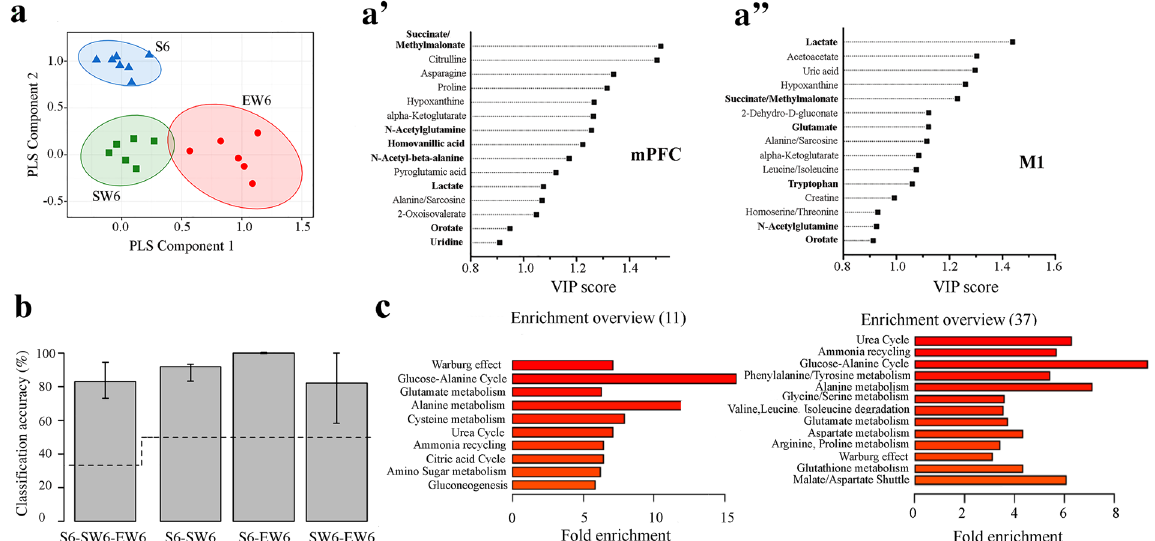
Figure 7. PLSDA and associated VIP classification model. By combining the mPFC and M1 analyses, data from S6, EW6, and SW6 were used in the PLSDA to determine the overall variation between treatment conditions. ( a ) PLSDA plot showing significant separation of EW6 from S6 and SW6 in Component 1, and additional separation of S6 from SW6 and EW6 in Component 2. Each symbol indicates data from one mouse. Ellipses represent a confidence interval of 95%. VIP score plots for mPFC (a’) and M1 (a”), showing the 15 metabolites with the highest VIP scores. The bold text indicates the metabolites identified by LME analyses. ( b ) Classification accuracy of the logistic regression with ℓ2 regularization penalty. Error bars represent a non-parametric 95% confidence interval for the true accuracy estimated from the cross-validation data. The lower end of the confidence interval is above the chance line (dashed line) for all 4 comparisons. Abbreviations: mPFC, medial prefrontal cortex; M1, primary motor cortex; S, sleep; EW, enforced wakefulness; SW, spontaneous wakefulness; PLSDA (partial least squares discriminate analyses; VIP, variable importance of projection; LME, linear mixed effects. ( c ) Metabolite set enrichment analysis using the 11 metabolites differentially expressed between sleep and wake (left) and all 37 metabolites (right). Pathways with > 2-fold enrichment (all p < 0.05) are